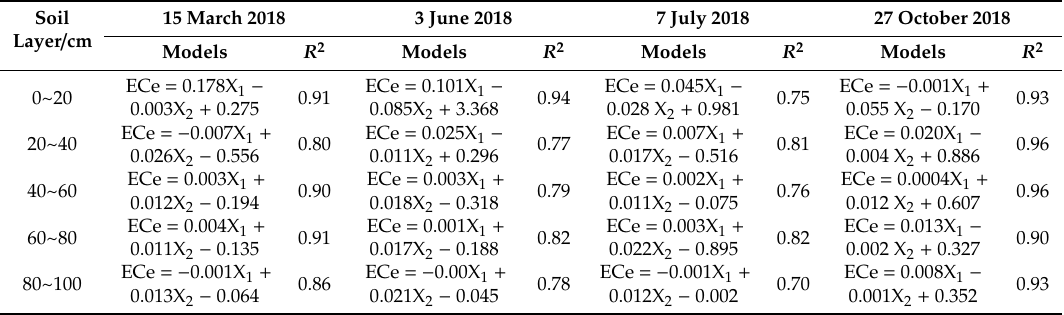
Table 2. Predictive relationship of soil conductivity at di ff erent depths and